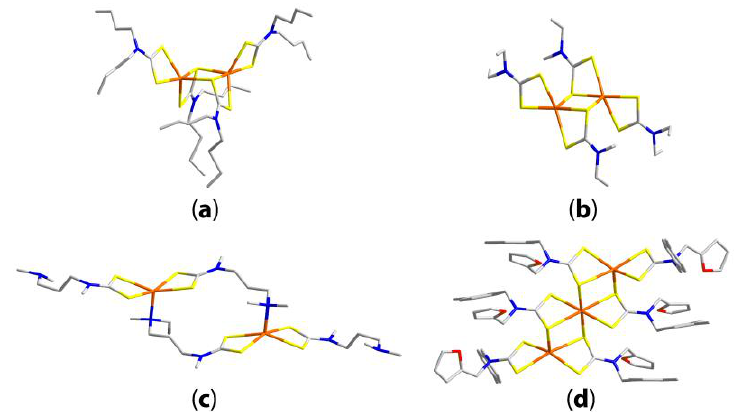
Figure 11. Molecular structures of ( a ) dimeric (2-fold symmetry) {Cd[S 2 CN(n-Bu) 2 ] 2 } 2 ( 101 ), ( b ) dimeric (inversion symmetry) {Cd[S 2 CN(n-Bu) 2 ] 2 } 2 ( 102 ), ( c ) dimeric {Cd[S 2 CN(Me)(CH 2 ) 3 NMe 2 ] 2 } 2 ( 124 ), and ( d ) trimeric {Cd[S 2 CN(CH 2 C 6 H 4 -4-Me)CH 2 (furyl)] 2 } 3 ( 127 ).